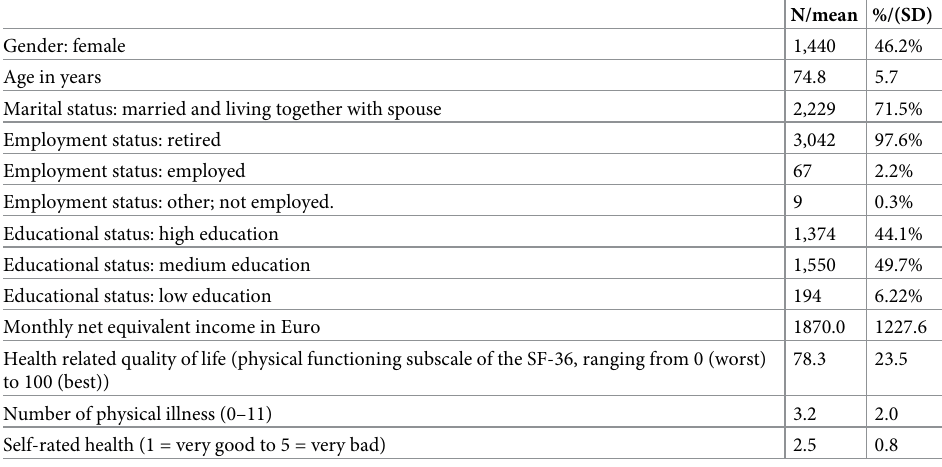
Table 1. Characteristics of the analytical sample (n = 3118